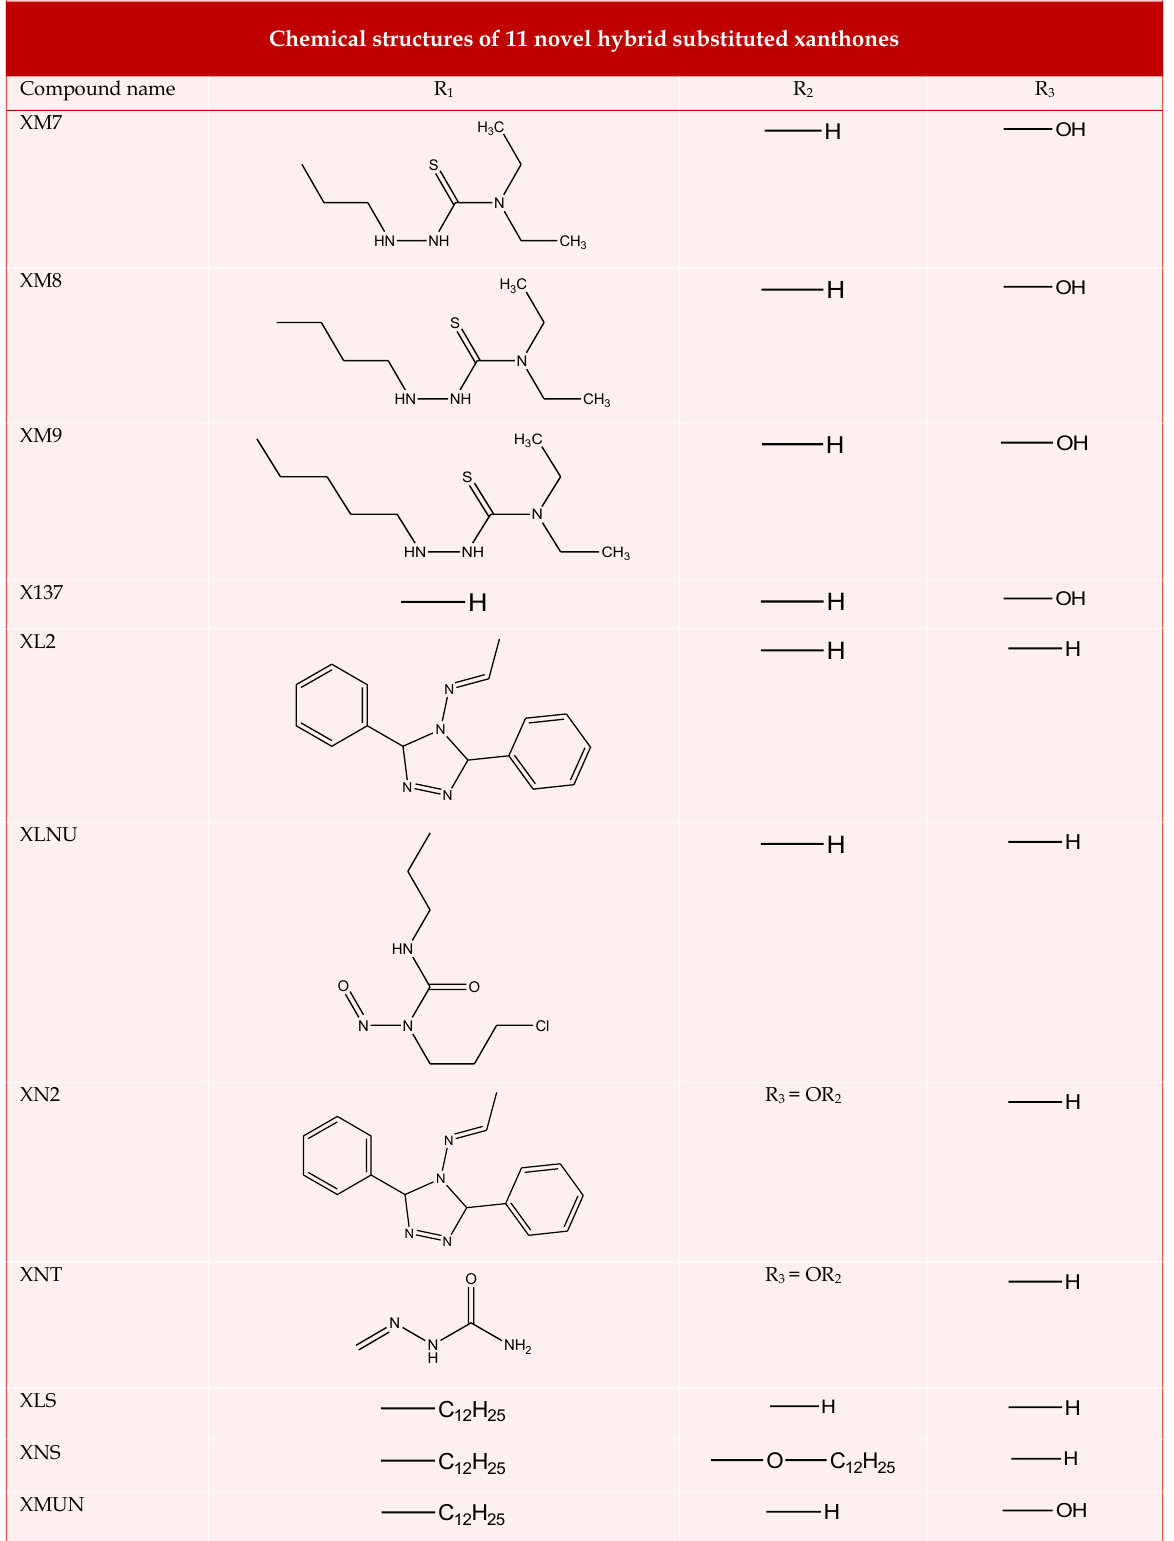
Chemical structures of 11 novel hybrid substituted